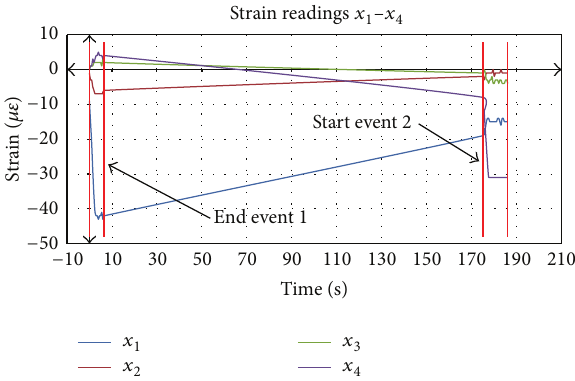
Figure 40: Total increase in strain in direction 𝑦